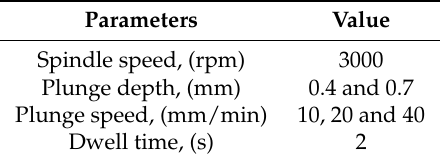
Table 4. List of welding parameters during the friction stir spot